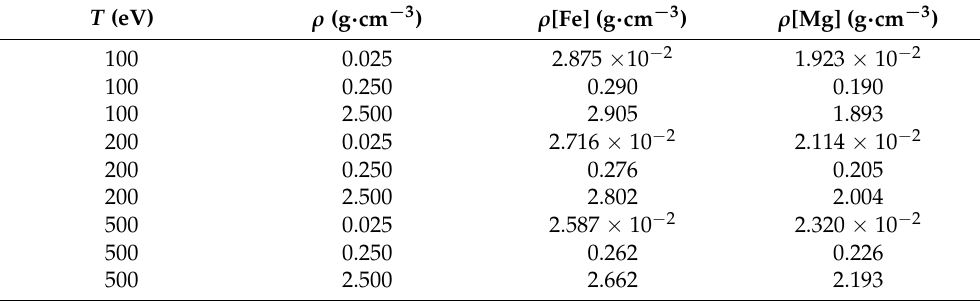
Table 3. Partial densities of iron and magnesium for a mixture plasma (number fractions of Fe and Mg are both equal to 0.5) at different temperatures (100, 200, and 500 eV) and densities (0.025, 0.25, and 2.5 g cm − 3 ). The partial densities are obtained by applying the same electronic pressure to all · ions in the plasma